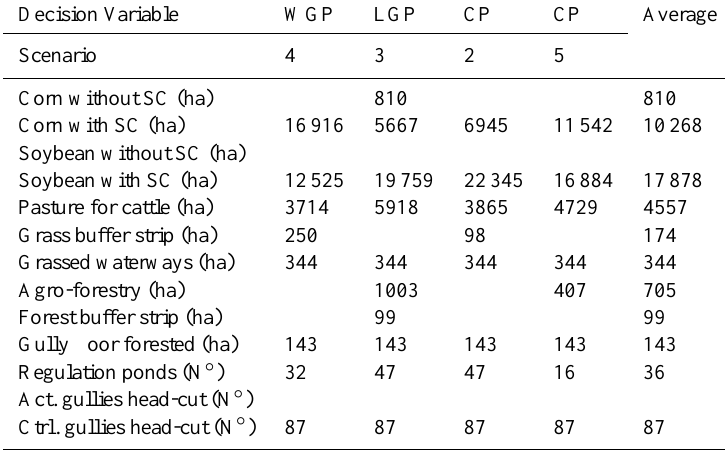
Table 4. Four feasible solutions for different GP MCDM for La Colacha basin.